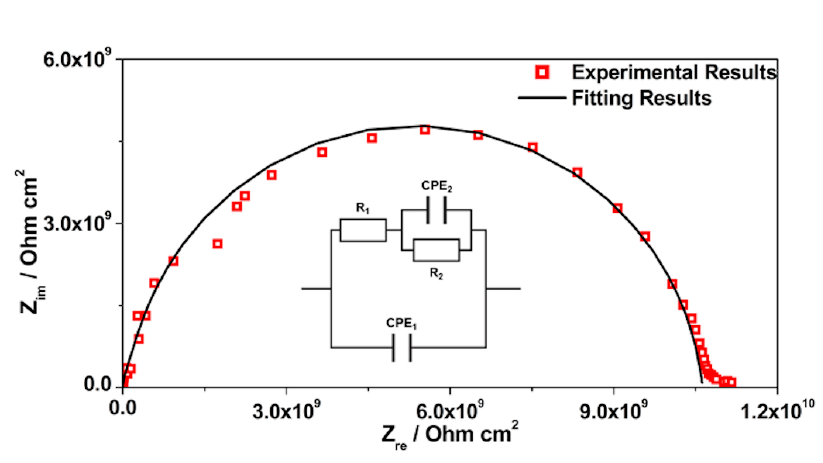
Figure 6. Nyquist plot for pure OIH AES(800)-1 / 2.5.